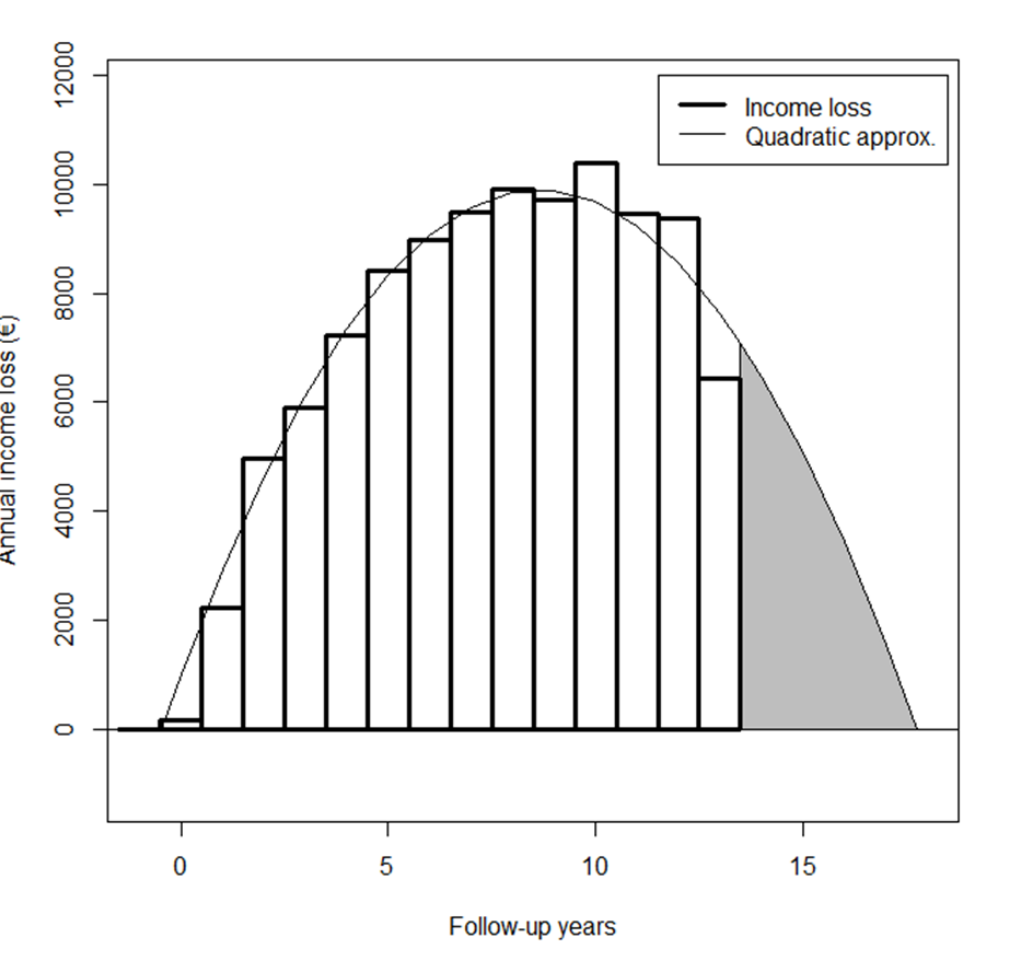
Figure 2: Estimated annual income loss per cancer case, with quadratic curve estimation of life-long